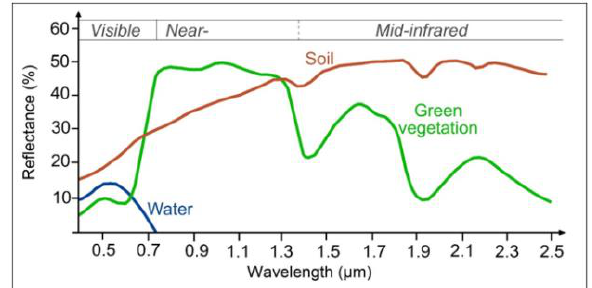
Figure 4 . Spectral reflectance curve